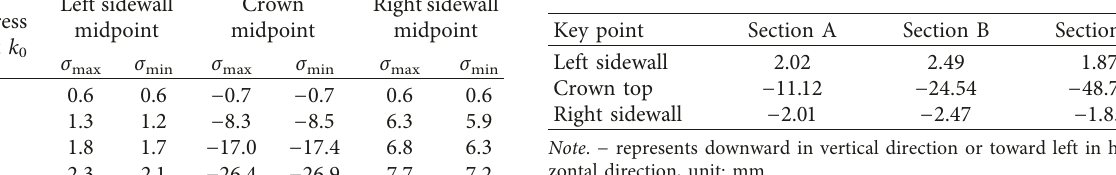
� 0.38; (b) k � 1.0; (c) k � 1.5; (d) k � 2.0; (e) k � 3.0. 0 0 0 0 0 Table 4: Displacement of the mining tunnel key point during